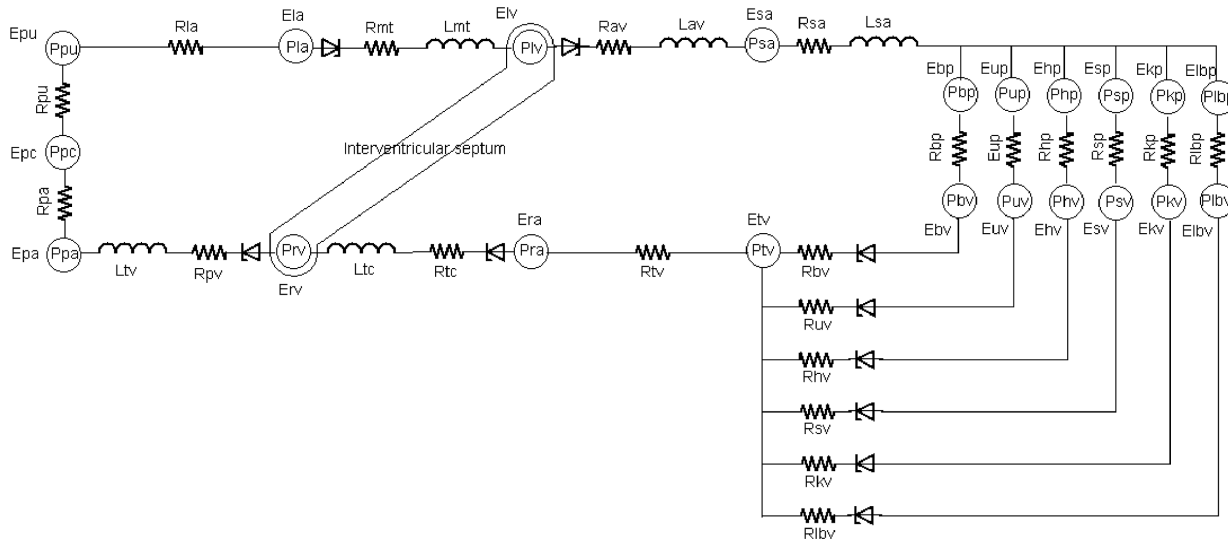
Figure 1. Electrical equivalent circuit analogue of the cardiovascular system (CVS) model. P , pressures; R , resistances; E , elastances (=1/ compliances); L , inertances. The CVS system includes (1) heart chambers consisting of the left and right atria, as well as the left and right ventricles; (2) pulmonary circulation consisting of the series arrangement of the arteries, capillaries and venous circulation; and (3) systemic circulation consisting of the large arteries and distinguishing between the peripheral and venous circulation of six parallel vascular districts: cerebral, upper body, coronary, splanchnic, renal, and lower body. Abbreviations: la, left atrium; lv, left ventricle, sa, large arteries; bp & bv, cerebral arteries & veins; up & uv, upper body arteries and veins; hp & hv, coronary arteries and veins; sp & sv, splanchnic arteries and veins; kp & kv, renal arteries and veins; lbp & lbv, lower body arteries and veins; tv, thoracic veins; ra, right atrium; rv, right ventricle; pa, pulmonary arteries; pc, pulmonary capillaries; pu, pulmonary veins.